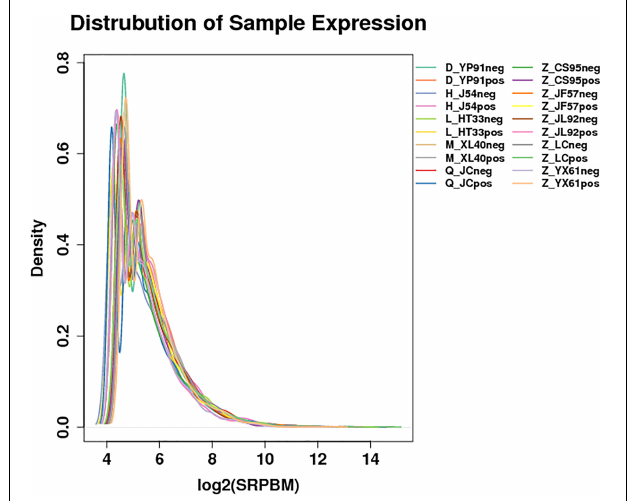
FIGURE 3 | Novel lncRNAs: Venn diagram results using different software prediction tools, including coding–non-coding index (CNCI), coding potential calculator, protein folding domain database (PFAM), and coding potential assessing tool software, showing upregulated and downregulated lncRNAs whose dysregulated expression pattern was shared by 10 patients with